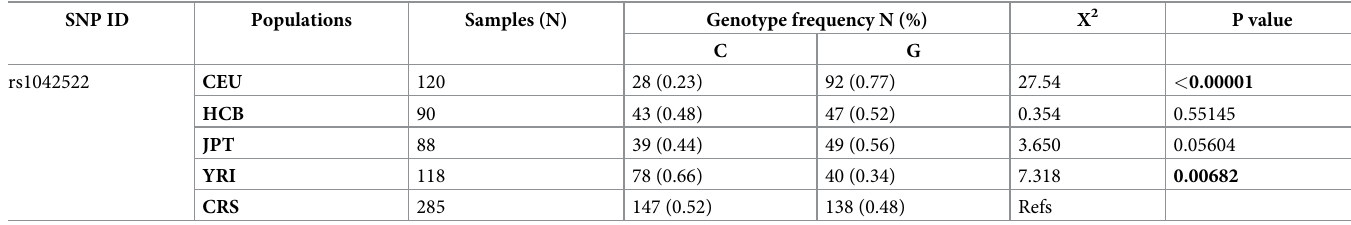
Table 8. Comparison of P53 SNP frequency in different populations.